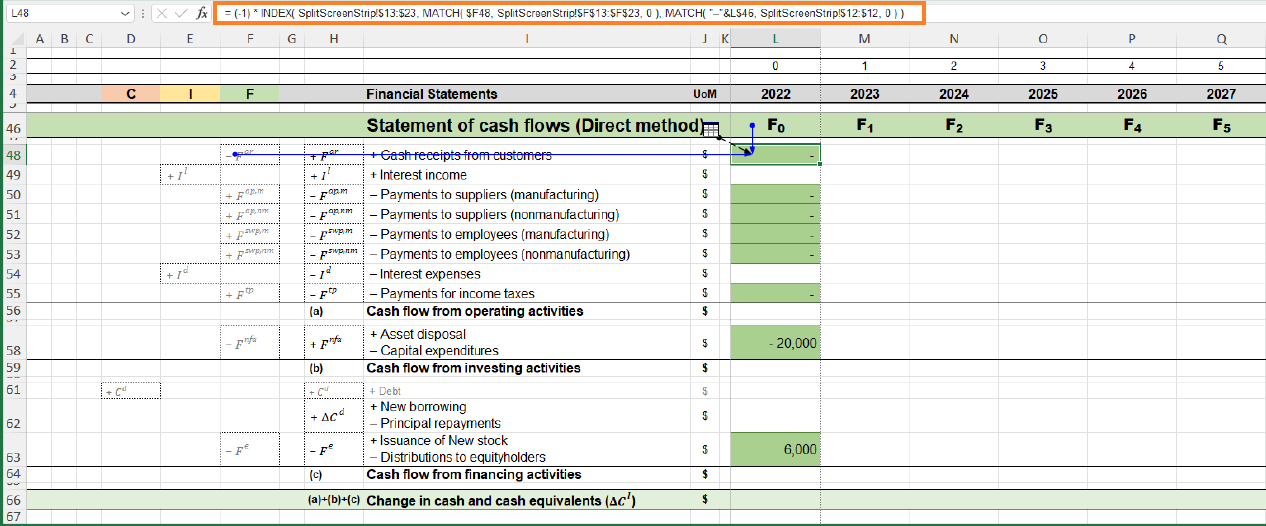
Figure 54. Cell L48 contains the formula for picking up the cash receipts from customers, + F ar , of period 𝑡 = 0 (“ConventionalFinStat” sheet).